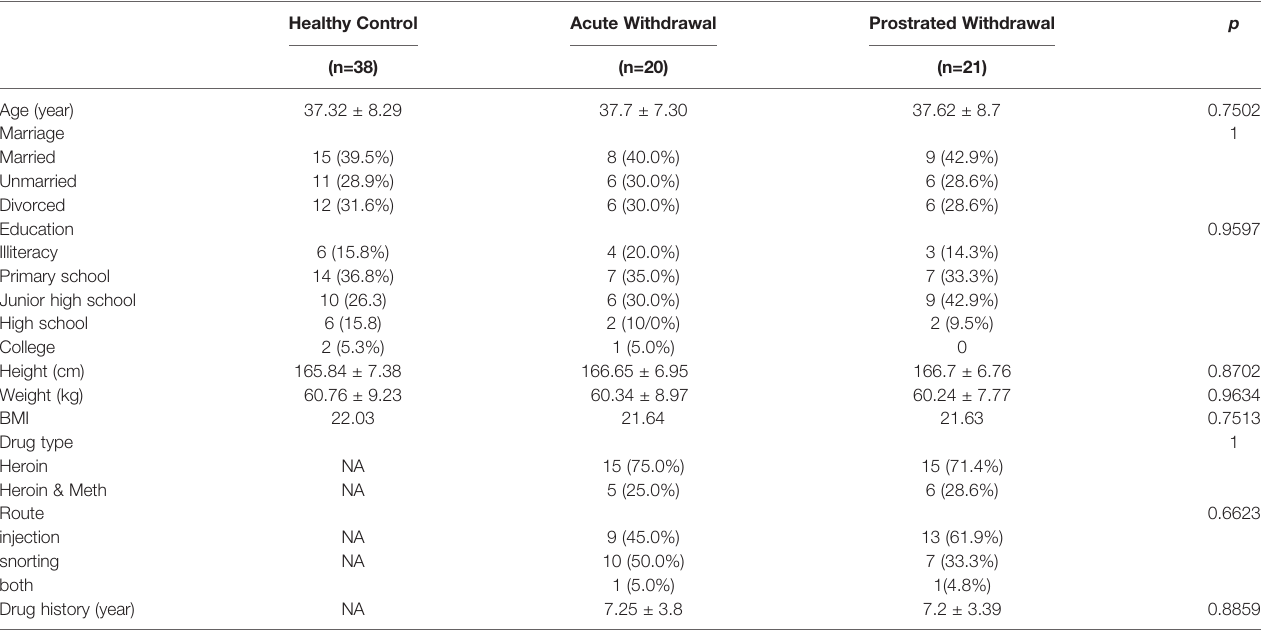
TABLE 1 | Demographic and Clinical Characteristics of all participants. Healthy Control Acute